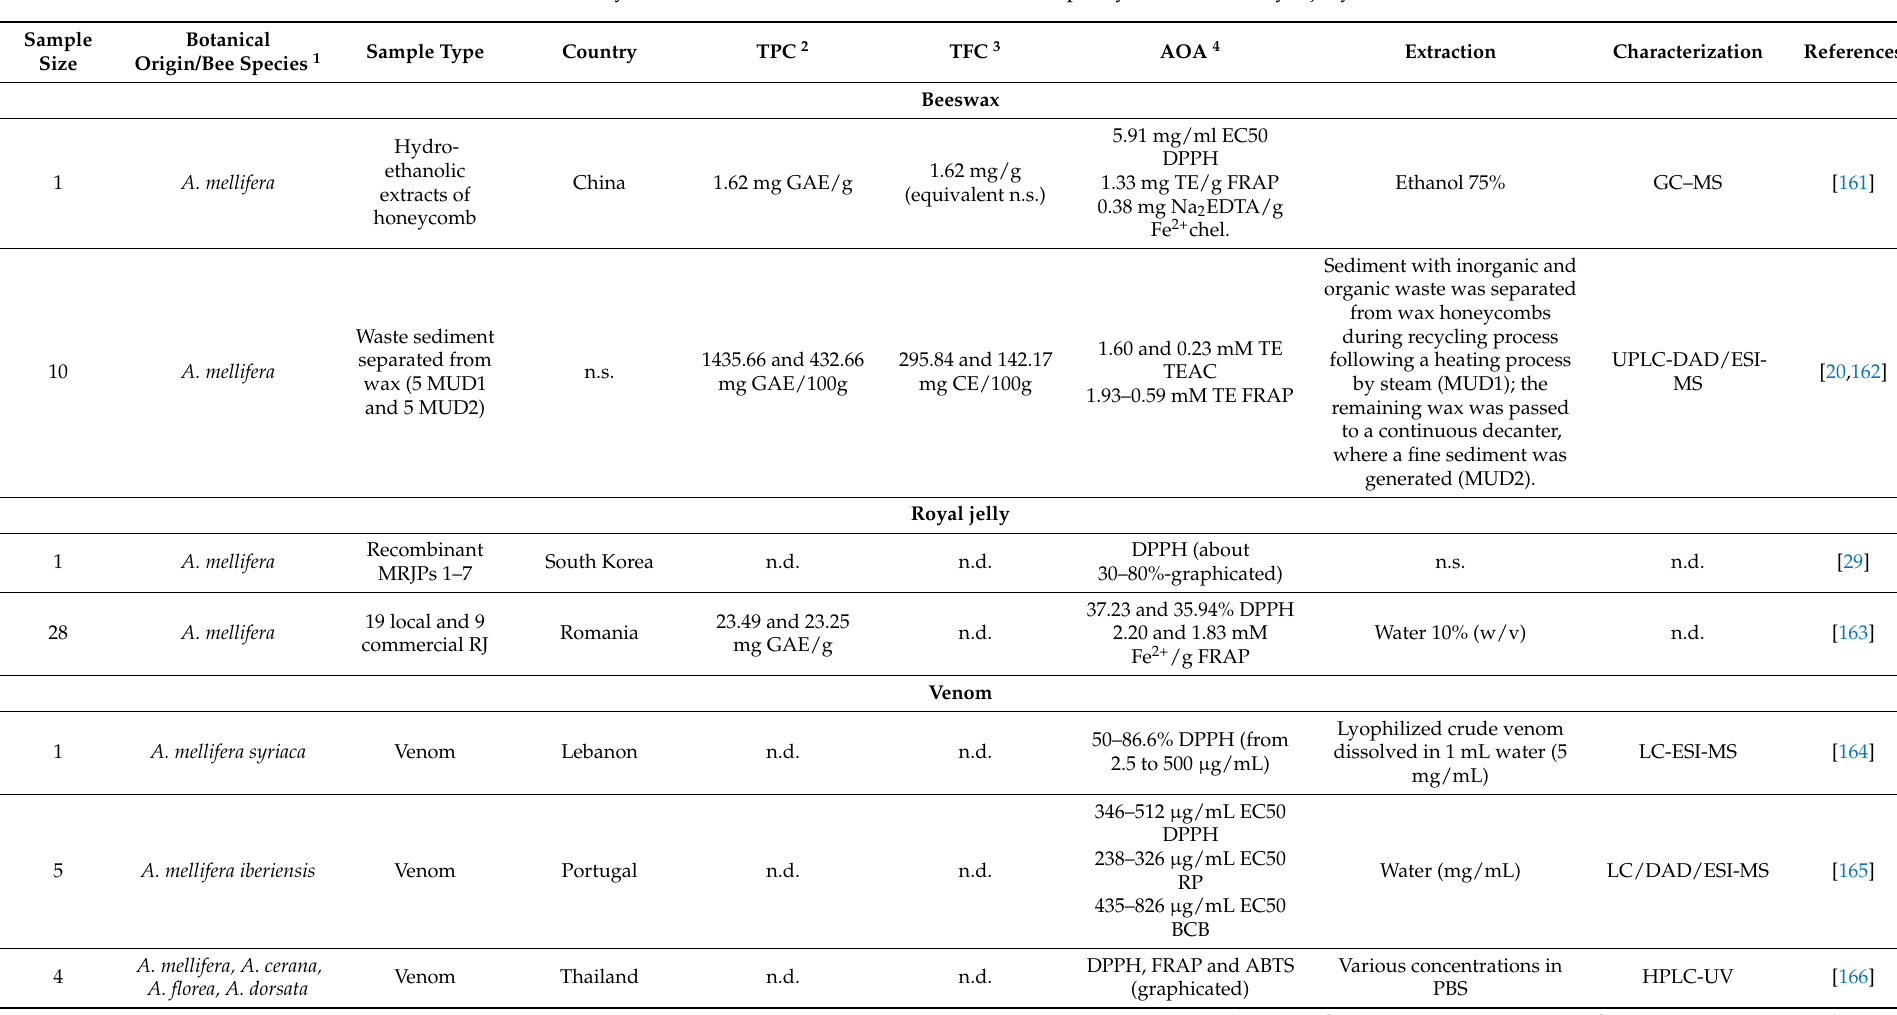
Table 5. Summary of the results from studies on antioxidant capacity in beeswax, royal jelly and